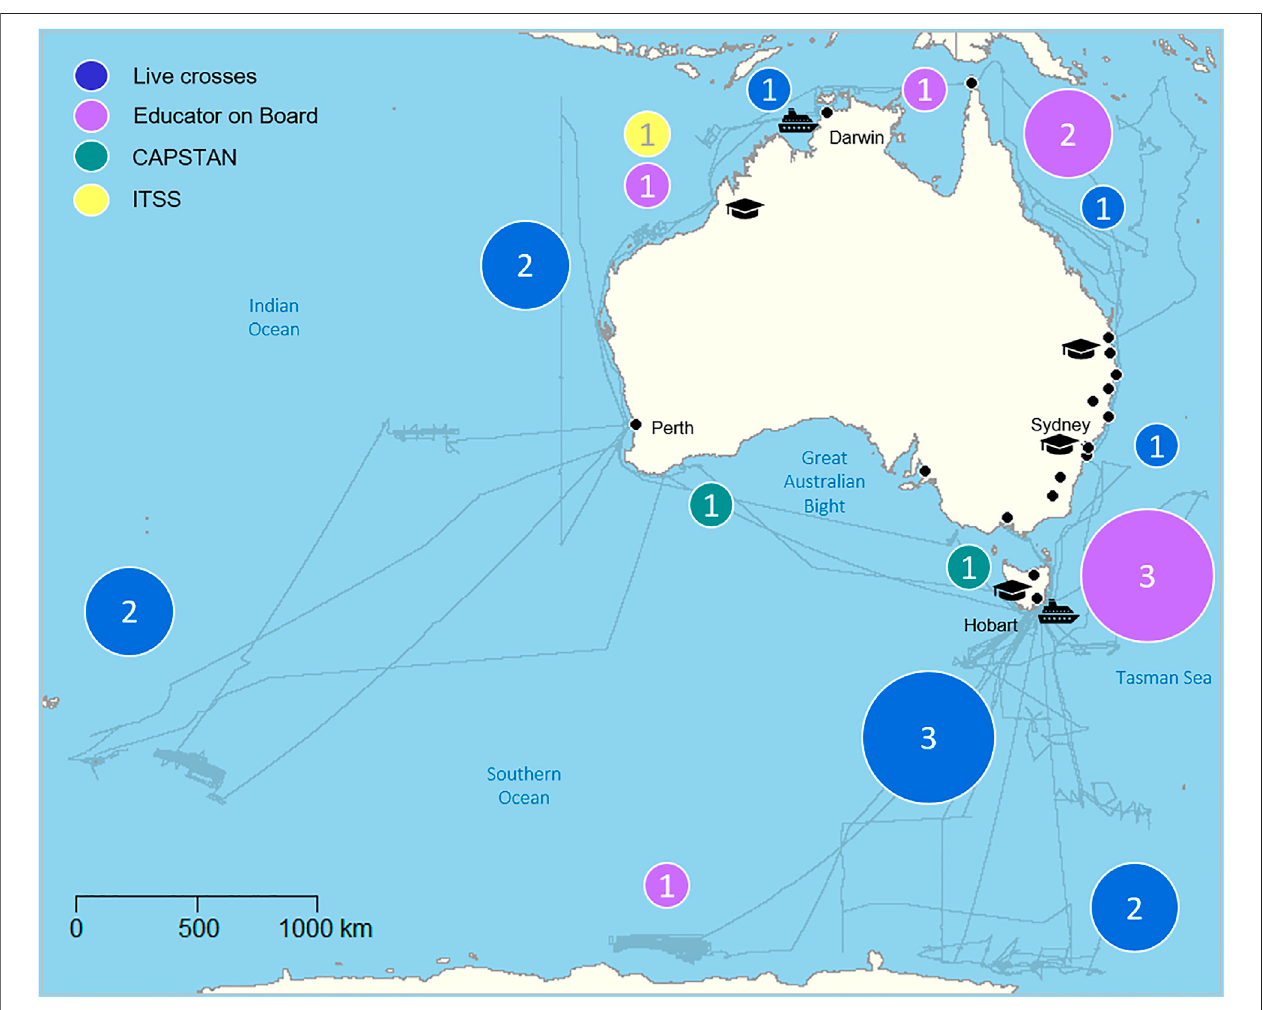
FIGURE2| MapofallactivitiesundertakenaspartoftheMNFOutreachprogram2016 – 20.Coloredcircleswithnumericalvaluesrepresentthenumberofvoyages hosting respective programs and activities grouped by geographic region. Voyage tracks are given in dark blue. Black circles indicate locations of audience for live ship linkups. Back pictograms represent ports that have hosted ship open days (ship) and Floating Classrooms (mortarboard).